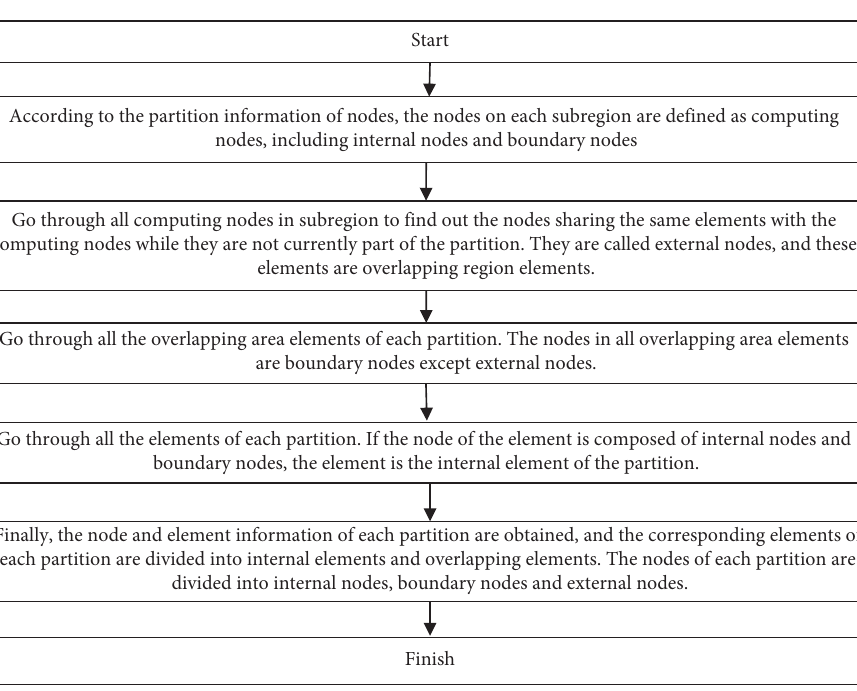
Figure 5: The process of domain decomposition based on overlapping elements.